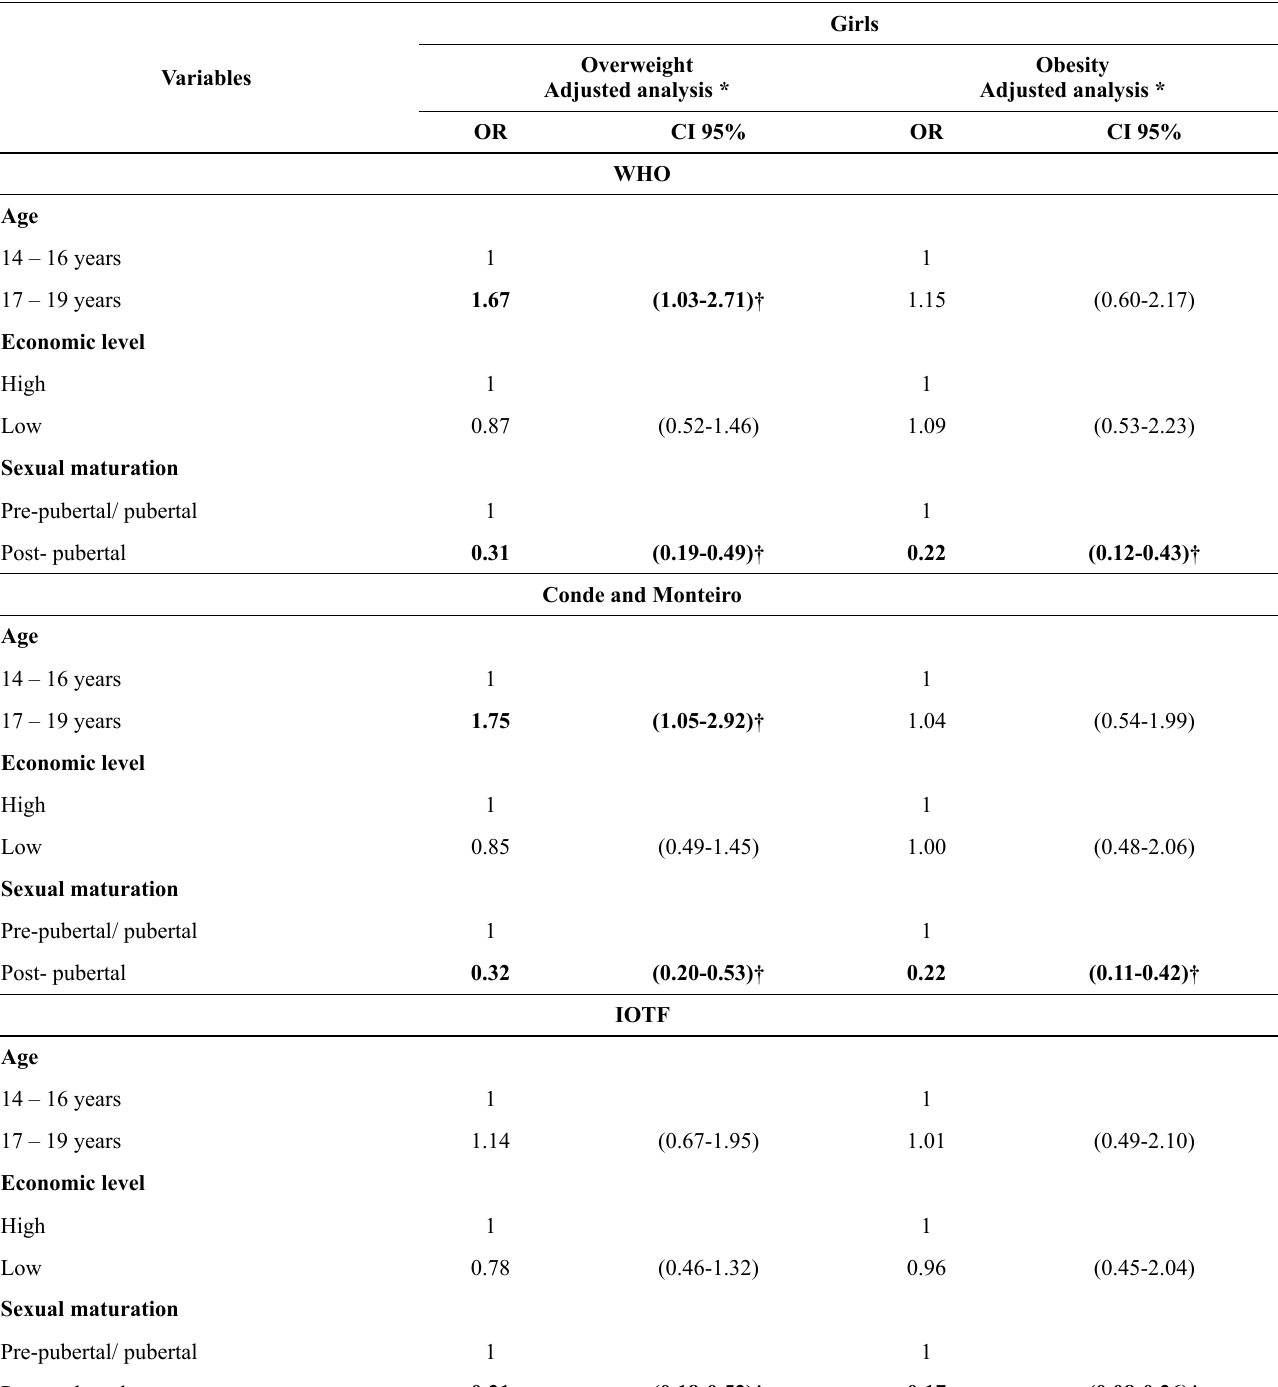
Table 4. Multinomial regression analysis adjusted between socio-demographic factors, sexual maturation and overweight and obesity